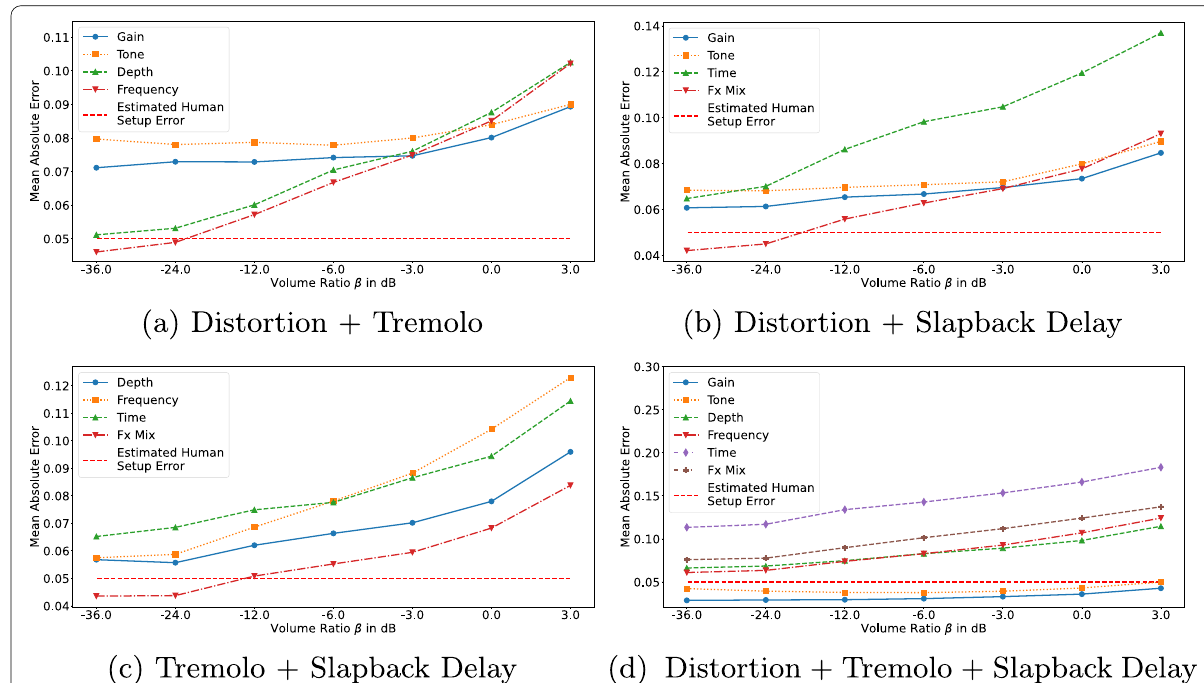
Fig. 10 Mean absolute error of the parameter extraction across volume of the convolutional neural network (CNN) for the effect chains using the spectrogram. Depicted are a distortion and tremolo, b distortion and slapback delay, c tremolo and slapback delay, and d distortion, tremolo, and slapback delay